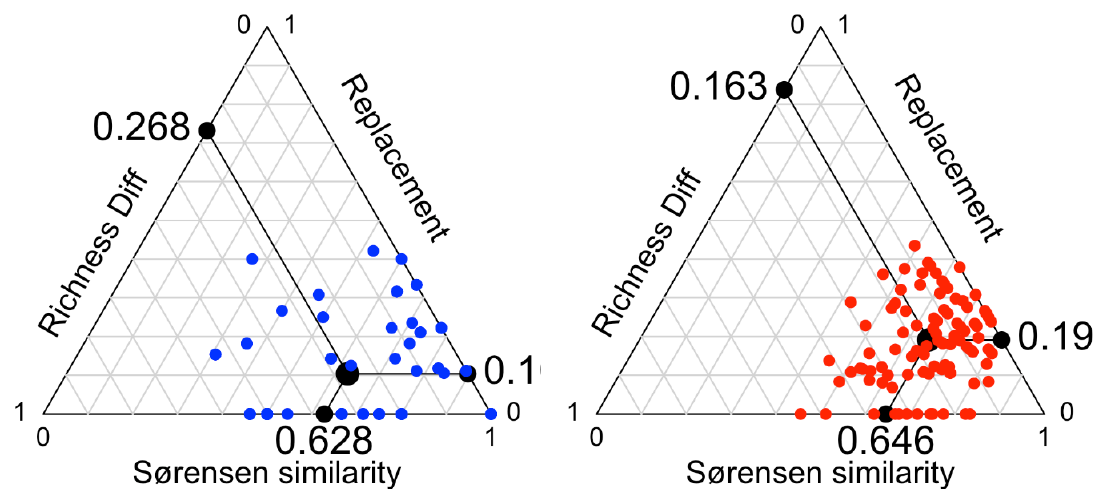
Figure 3. Simplex plots based on similarity, richness differences, and species replacement for all the pairwise comparisons of the Cladocera communities of the 15 sampling sites of the Cibakháza oxbow